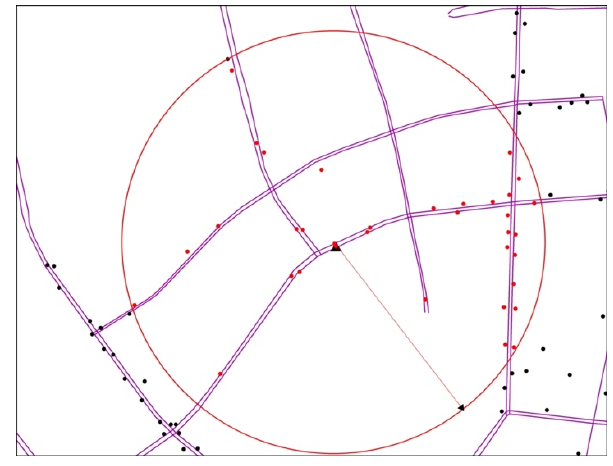
Figure 8. Subnearest-neighbor analysis.